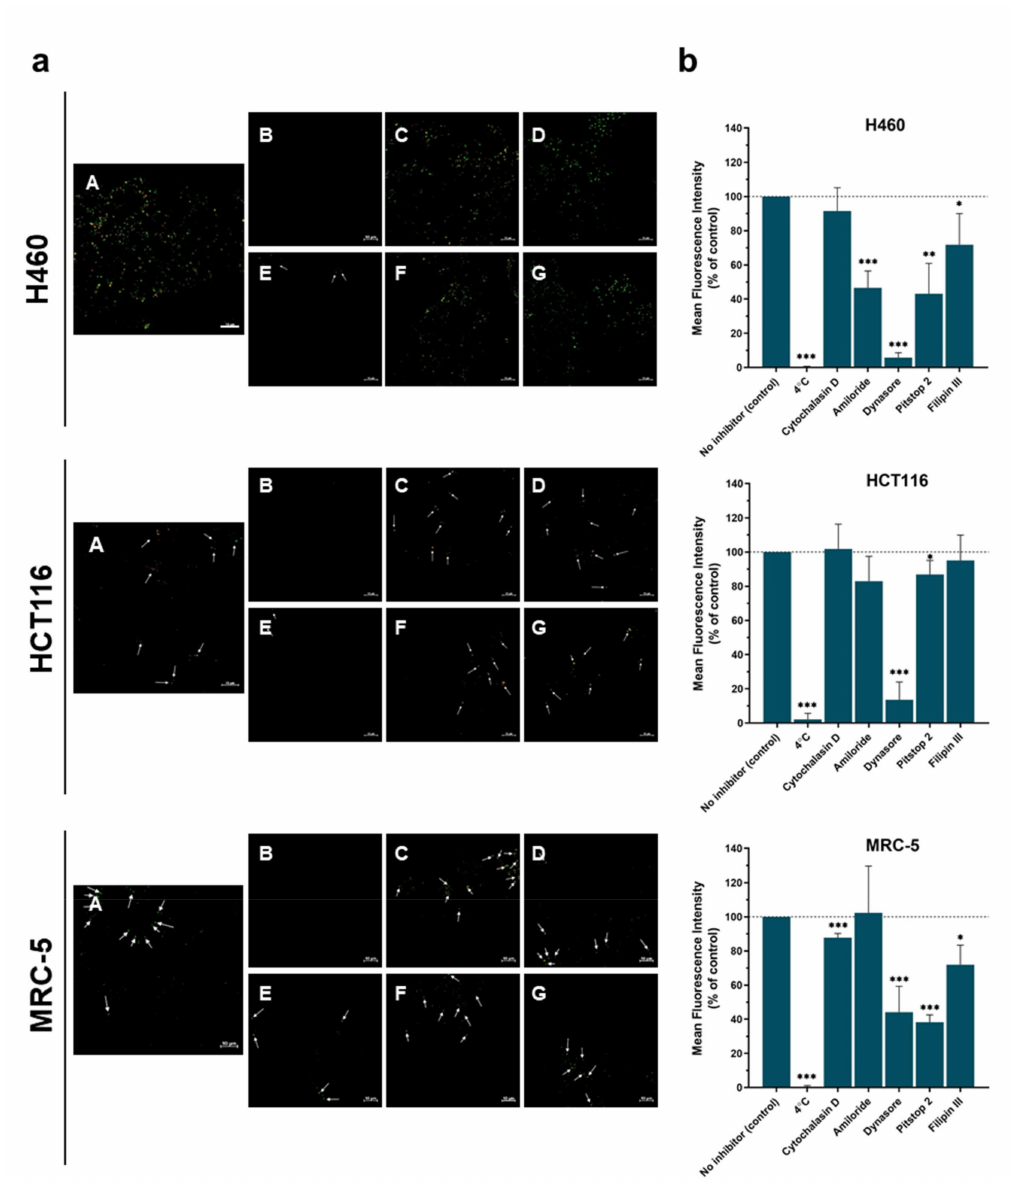
Figure 4. ( a ) The influence of different endocytosis inhibitors on the internalization of QD green -C-2028 in cancer and normal cells. H460, HCT116, and MRC-5 cells were preincubated with ( A ) drug-free medium (no inhibitor), ( B ) at 4 ◦ C, ( C ) 5 µ M Cytochalasin D, ( D ) 30 µ M Amiloride, ( E ) 80 µ M Dynasore, ( F ) 25 µ M Pitstop 2, and ( G ) 1.5 µ M Filipin III for 30 min, followed by further incubation with QD green -C-2028 for 4 h. The internalization of QD green -C-2028 in cells was explored by CLSM. Scale bar 10 µ m. ( b ) MFI values of the panel ( a ) were determined using ImageJ software and normalized to control (cells treated QD green -C-2028 without inhibitor). Data are expressed as the mean ± standard deviation of four independent experiments. * p < 0.05, ** p < 0.01, *** p < 0.001—statistically significant differences between the MFI of UAs and QDs in the cells incubated with inhibitors and control cells (no inhibitor) (Student’s t